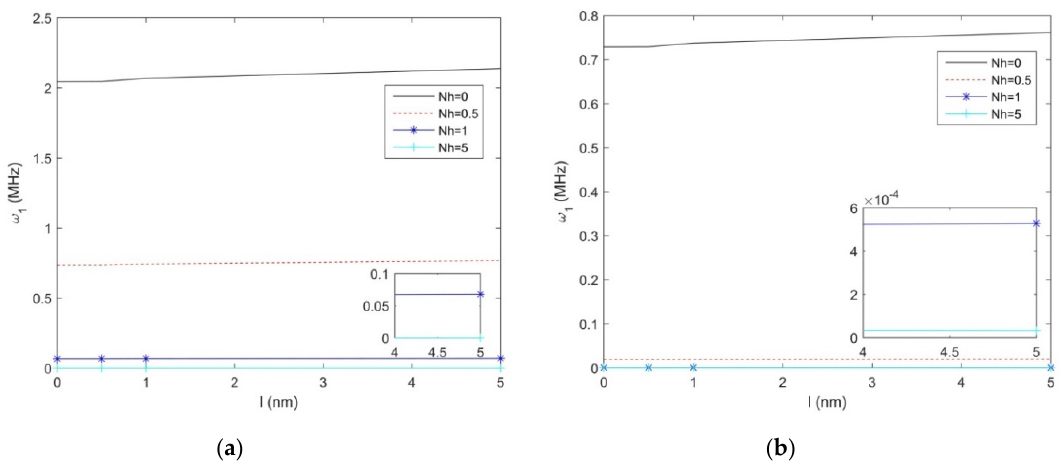
Figure 5. The 1st natural frequency variation for a S-S ( a ) and C-F ( b ) beam vs. length scale parameter for di ff erent non-uniformity